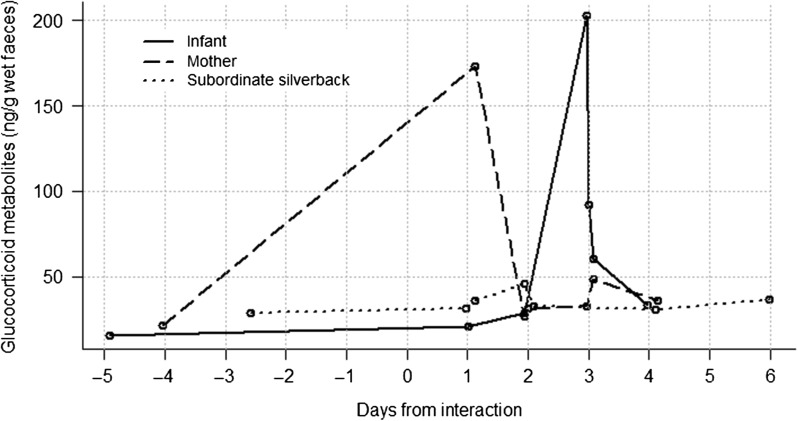
Faecal glucocorticoid metabolite concentration profiles of three individual gorillas from Ugenda group before and after an interaction with a solitary silverback. The infant lost a finger in the interaction.